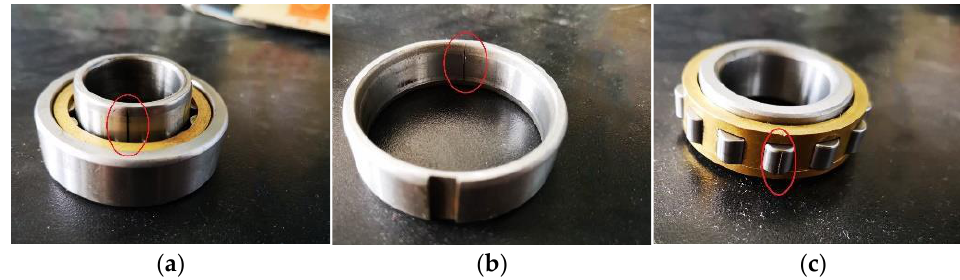
Figure 4. Different faults of rolling bearings: ( a ) rolling element ( b ) inner race ( c ) outer race.